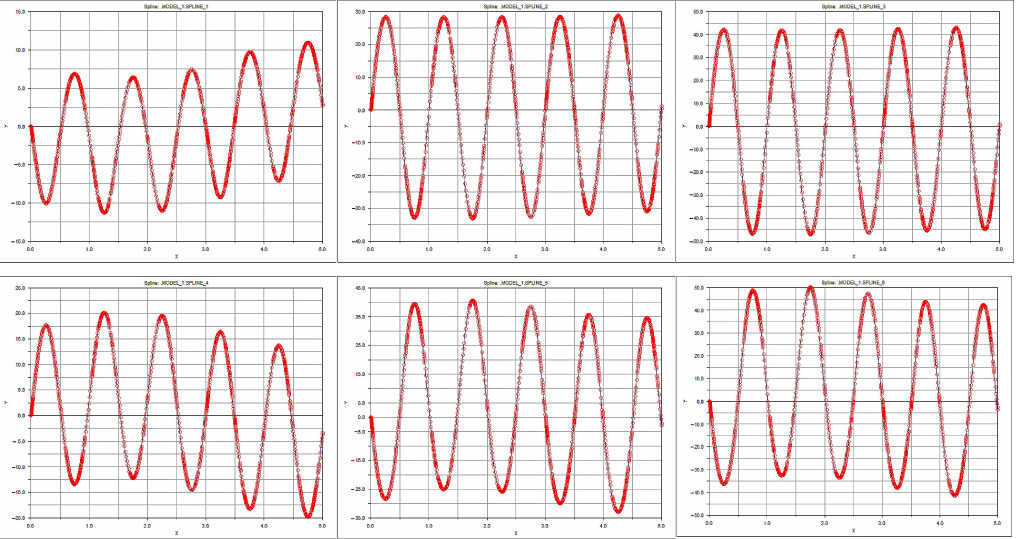
Figure 9. Electric cylinder driving curve.